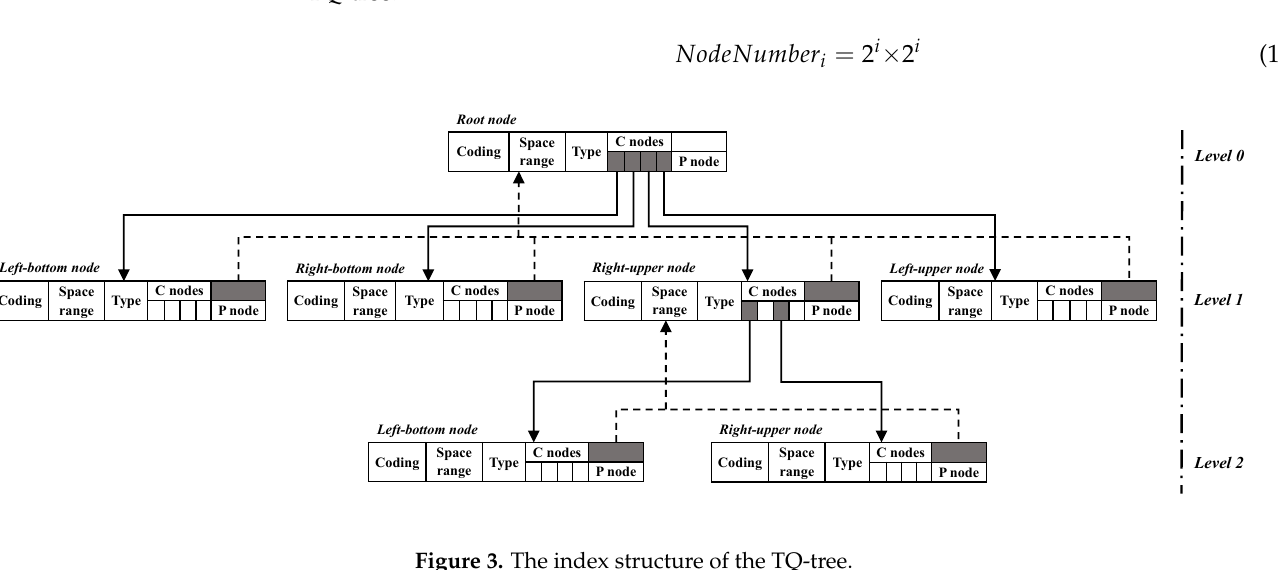
Figure 3. The index structure of the TQ-tree.